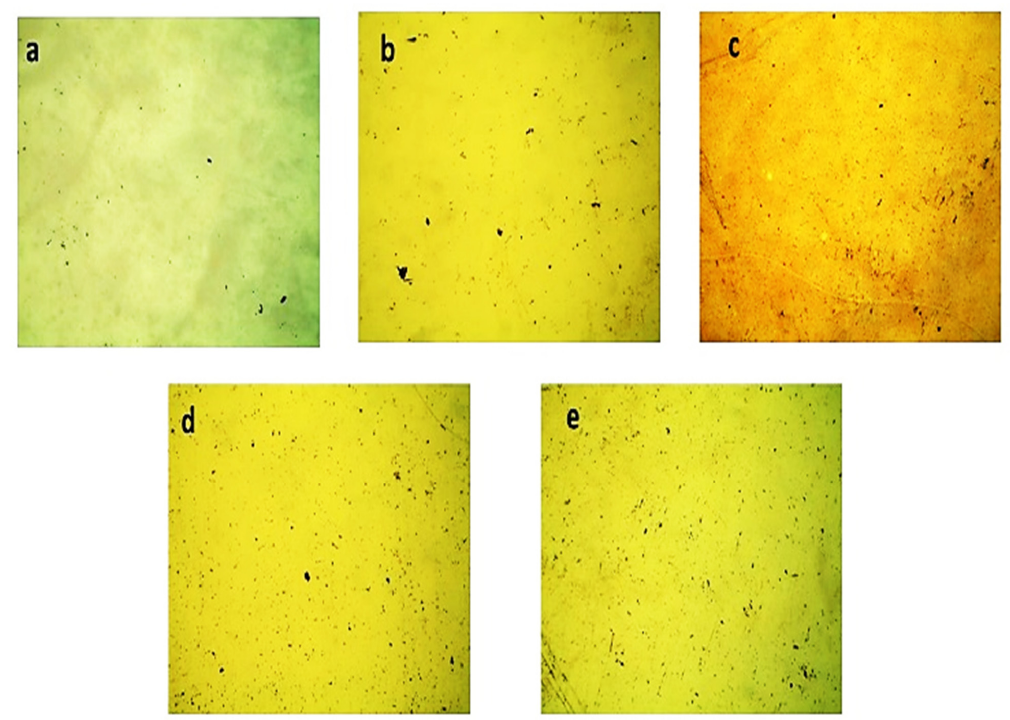
Figure 5. Pure AlSb-deposited thin films’ optical micrographs for time durations of ( a ) 1 h, ( b ) 1.5 h, ( c ) 2 h, ( d ) 2.5 h, and ( e ) 3 h.